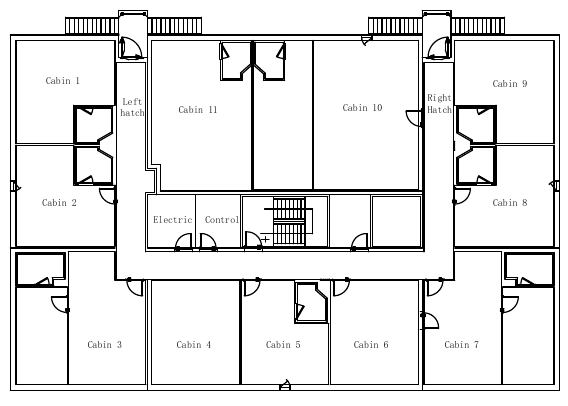
Figure 1. Deck plan.